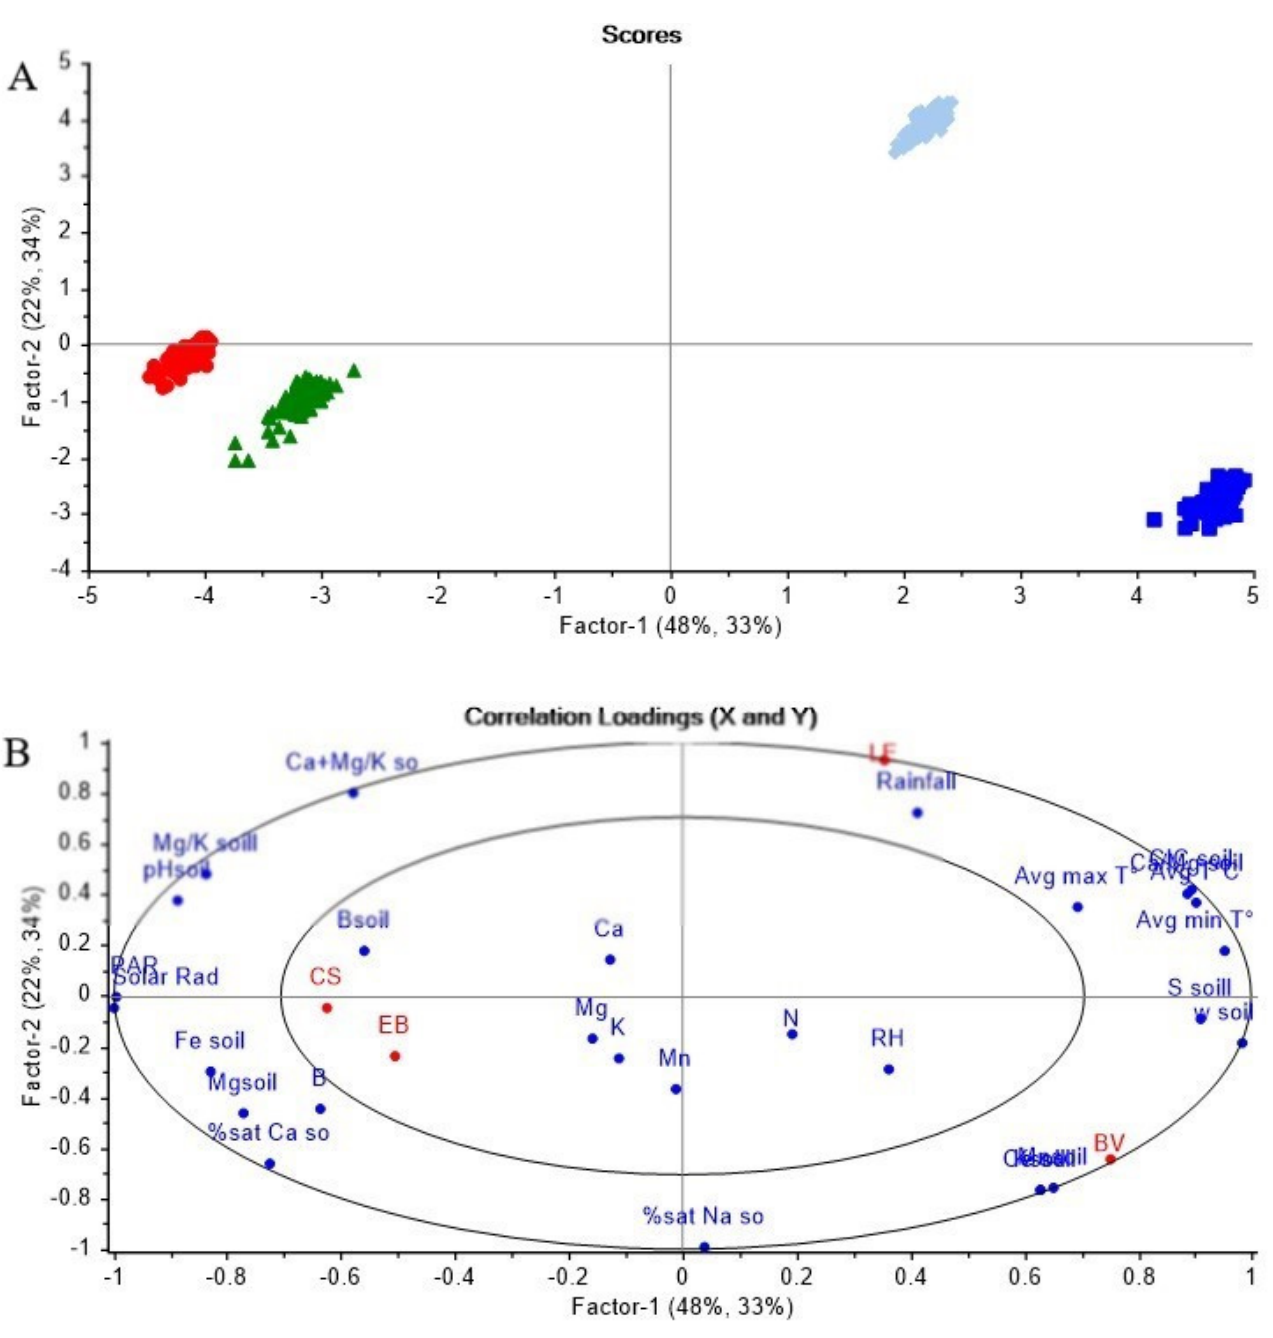
Figure 9. Score ( A ) and loading plot ( B ) of the Partial Least Squares-Discriminant Analysis (PLS-DA) for farms (LE, CS, EB, and BV) based on the preharvest parameters (weather and soil) and flesh mineral significant content.